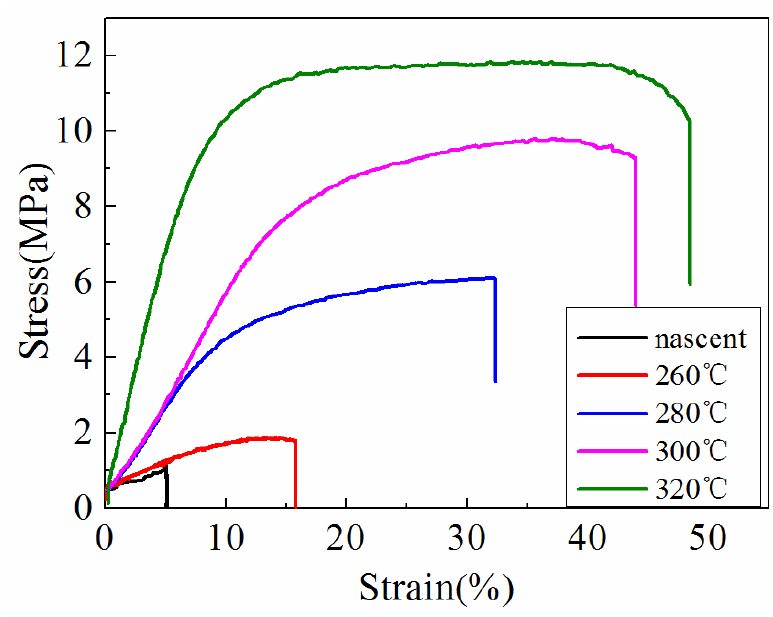
Figure 9. Stress–strain curves of the ultrafine fibrous FEP porous membranes at different sintering temperature (FEP/PVA mass ratio: 1:6).